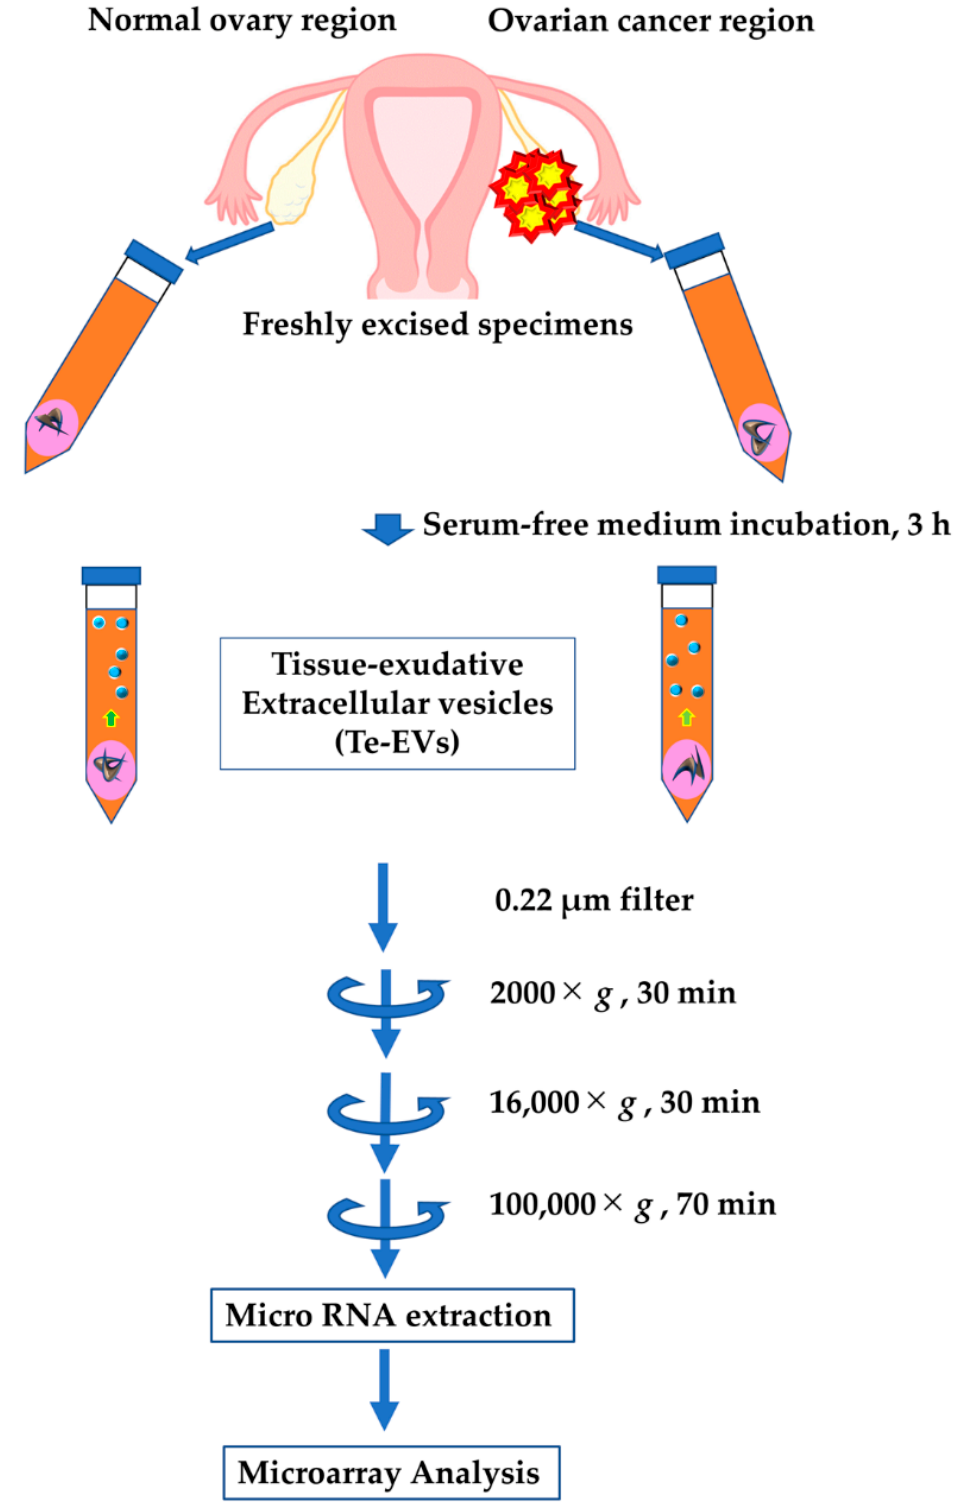
Figure 5. Isolation of Te-EVs and microarray search for miRNAs.